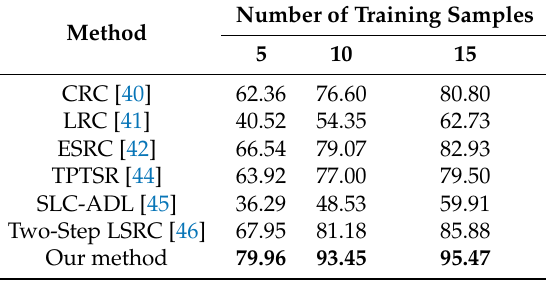
Table 5. Face recognition rates (%) of different methods on FRGC